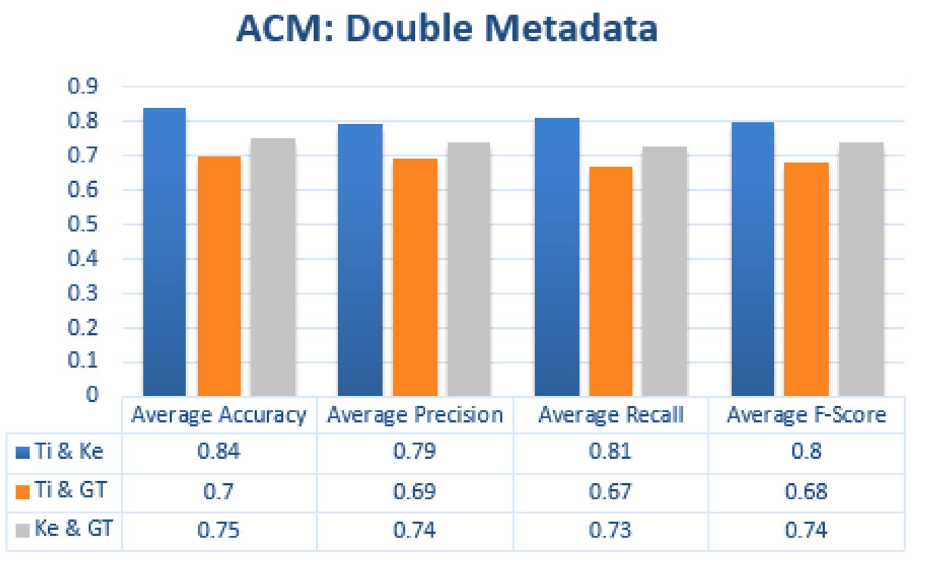
Figure 11. ACM (double